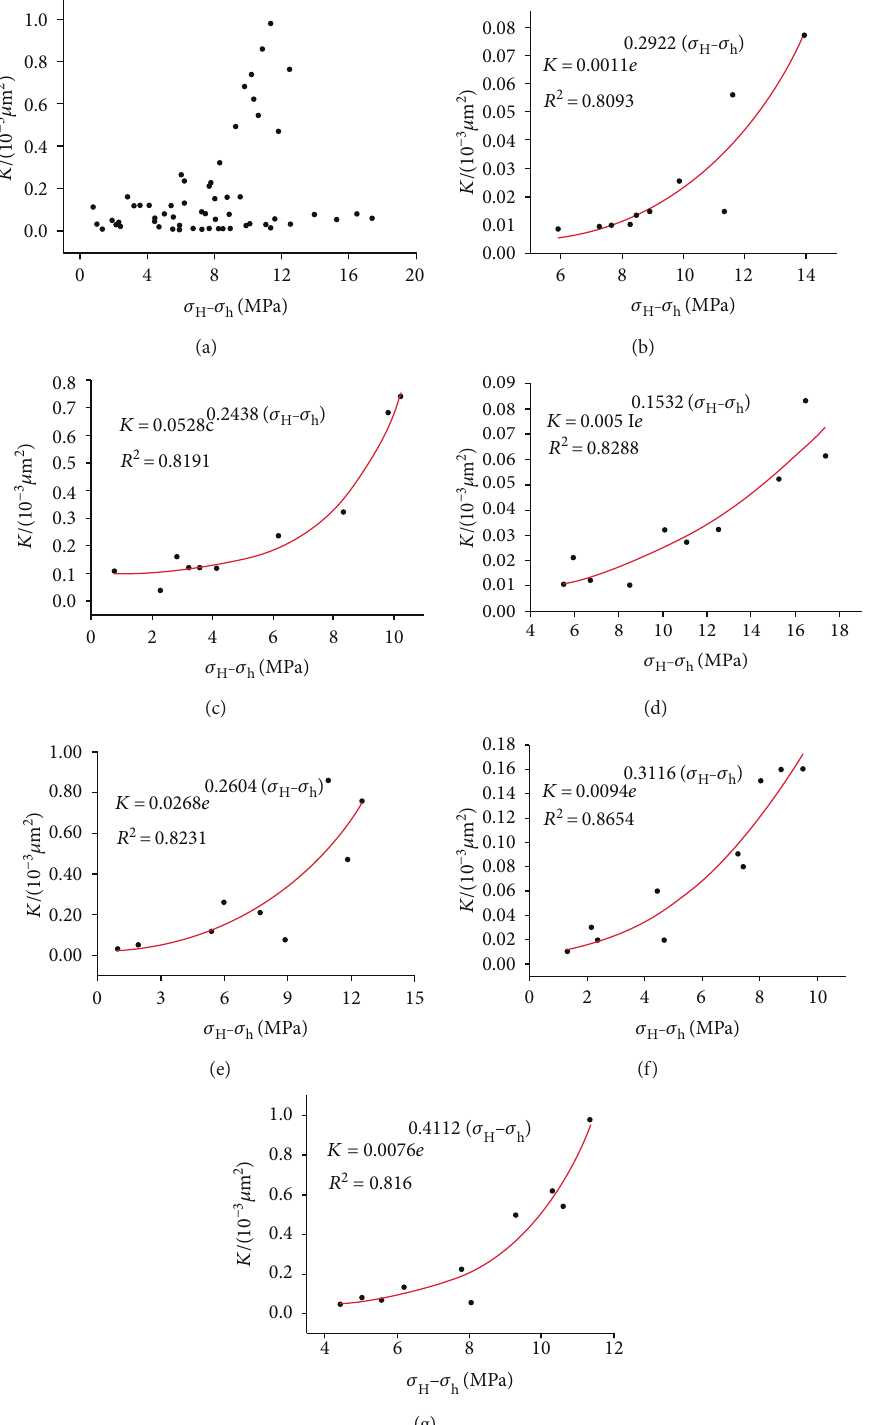
Figure 7: (a) The relationship between the stress di ff erence and permeability not divided into superimposed zones. (b) The relationship between the stress di ff erence and permeability on the Zone I. (c) The relationship between the stress di ff erence and permeability on the Zone II. (d) The relationship between the stress di ff erence and permeability on the Zone III. (e) The relationship between the stress di ff erence and permeability on the Zone IV. (f) The relationship between the stress di ff erence and permeability on the Zone V. (g) The relationship between the stress di ff erence and permeability on the Zone